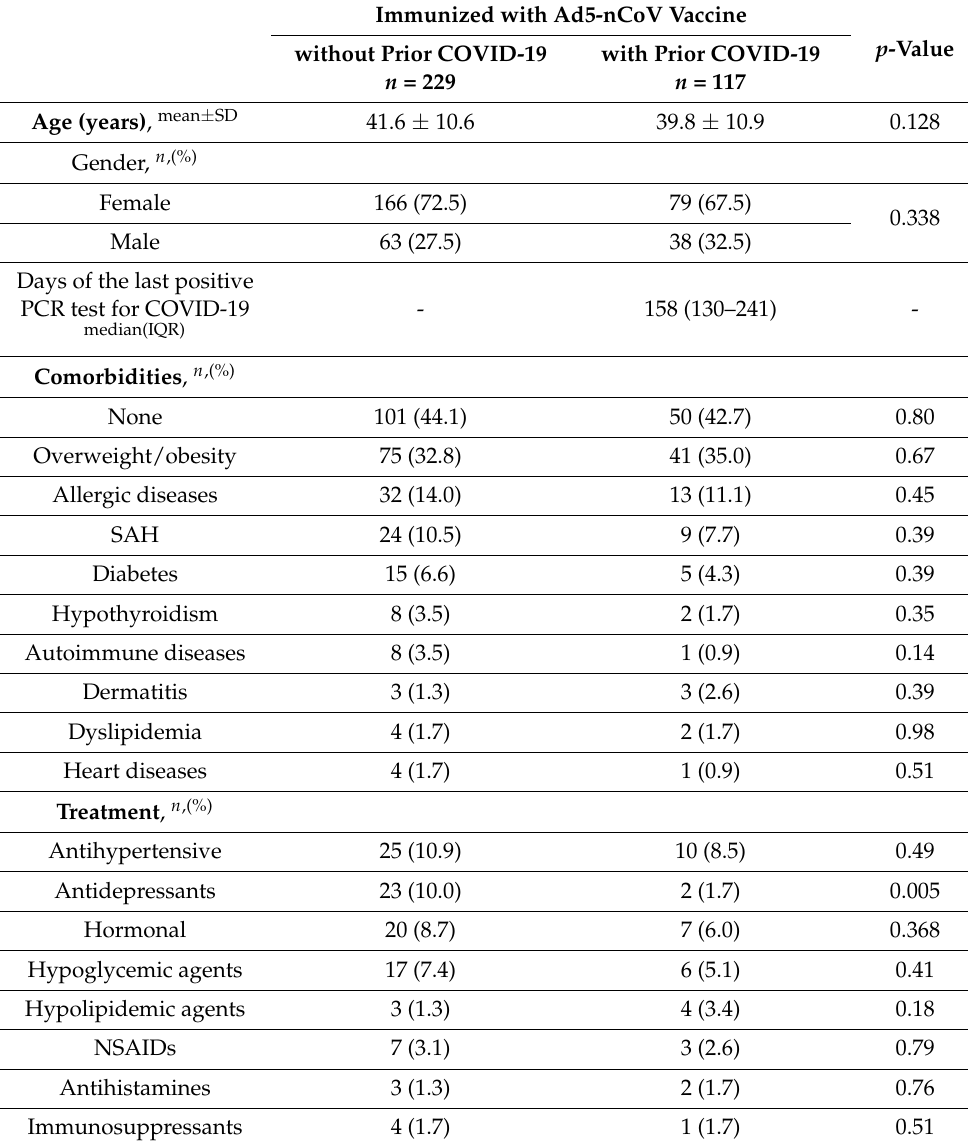
Table 1. Clinical and demographic characteristics of the study